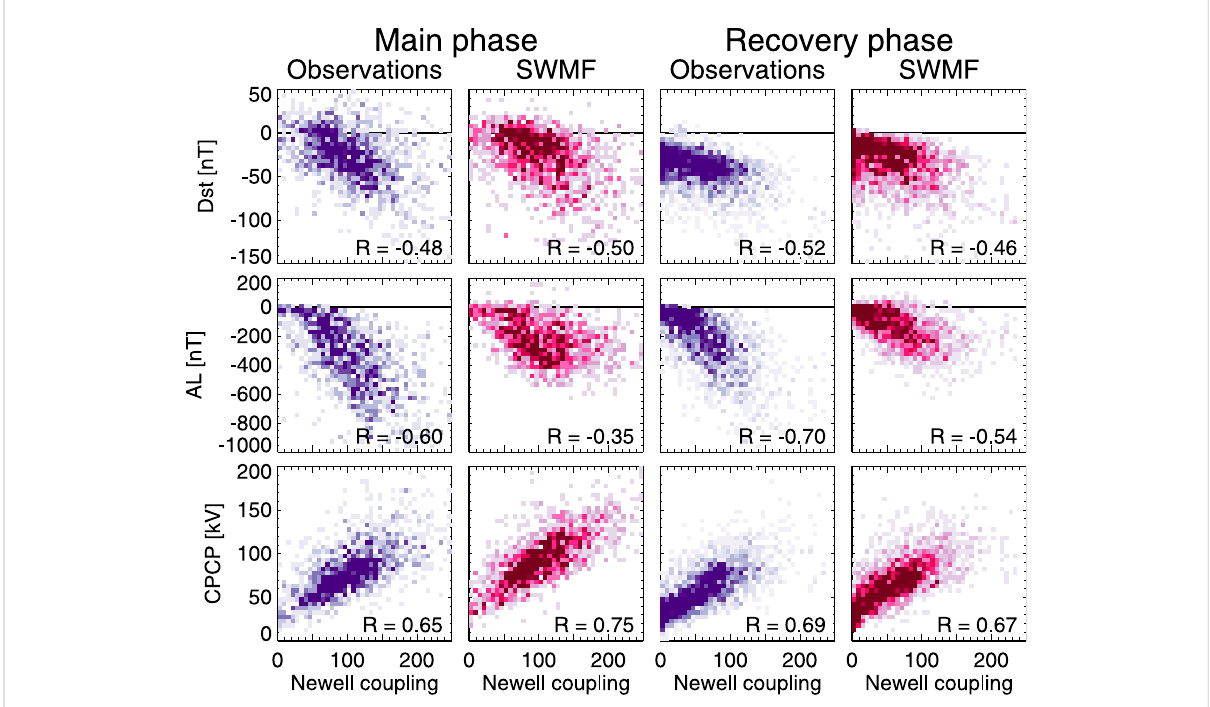
FIGURE 7 (Top row) Dst; (Middle row) AL; and (Bottom row) CPCP during (Left two columns) the storm main phase and (Right two columns) recovery phase as function of the Newellcoupling function (in arbitrary units) using 1-hour averaged data for observations (darkpurple) and simulations (dark red). The heat maps indicate the share of points falling ineach